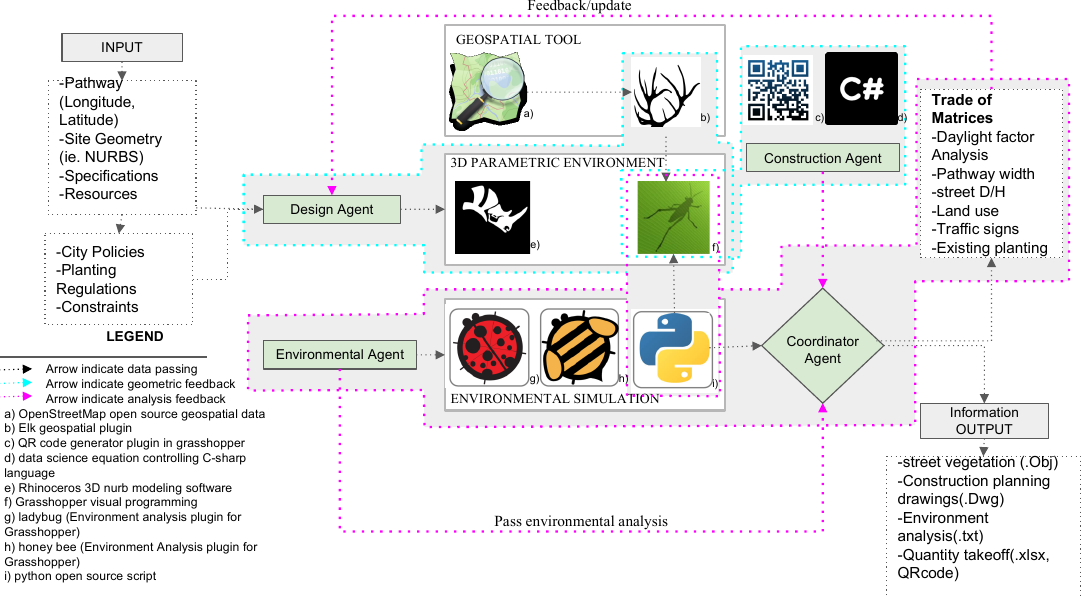
Figure 3. System Architecture for T-Design module.